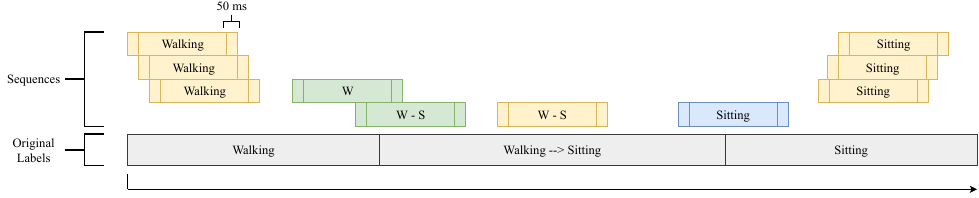
transition classification. Tables 2–4 show the number of sequences for the locomotion modes, transitions, and gait phases in the two data-sets.